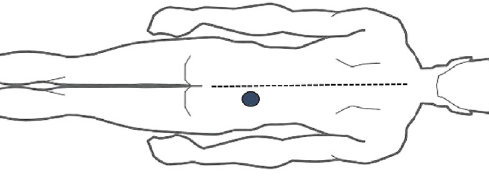
Figure 2: ALBP model